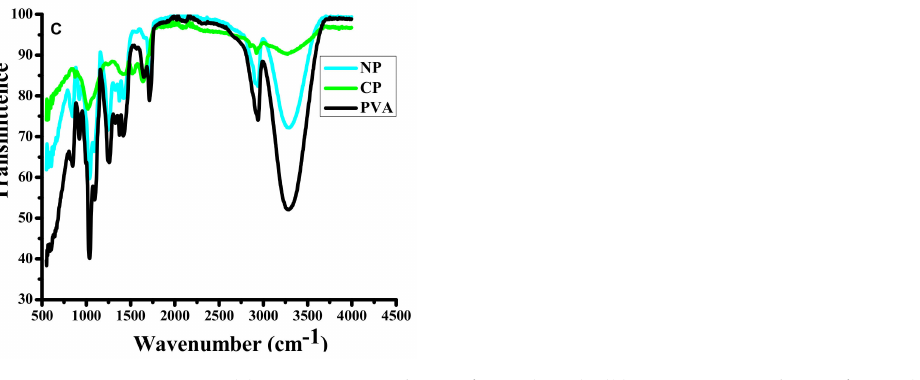
Figure 2. FTIR spectra, ( a ) pure PVA and PVA/NiO (NP3), ( b ) pure PVA and PVA/CuO (CP3), ( c ) comparison of PVA, NP3, and CP3.